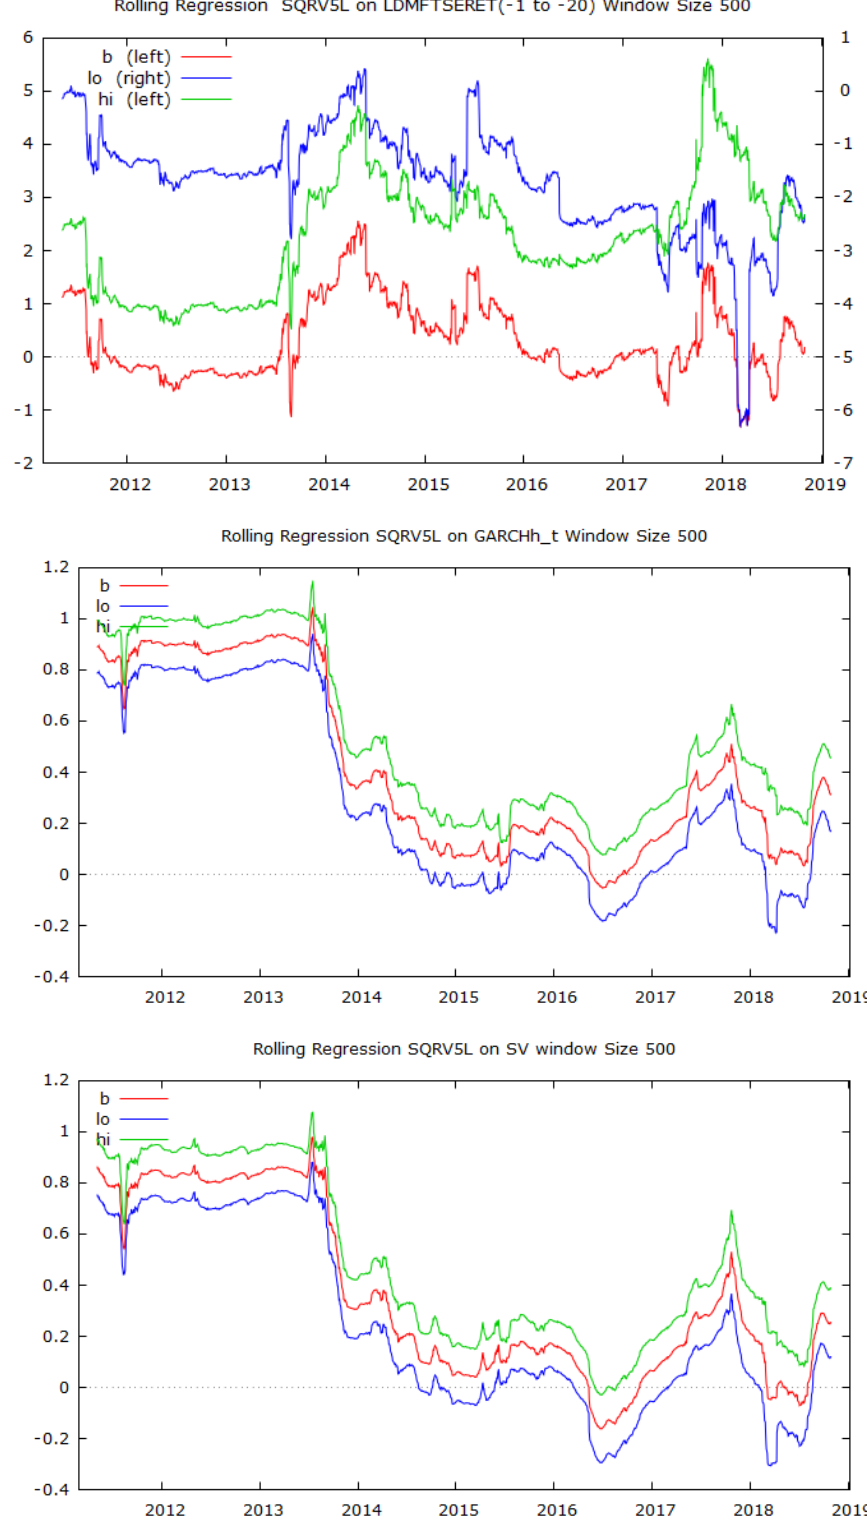
Figure A1. Rolling-regression—window size